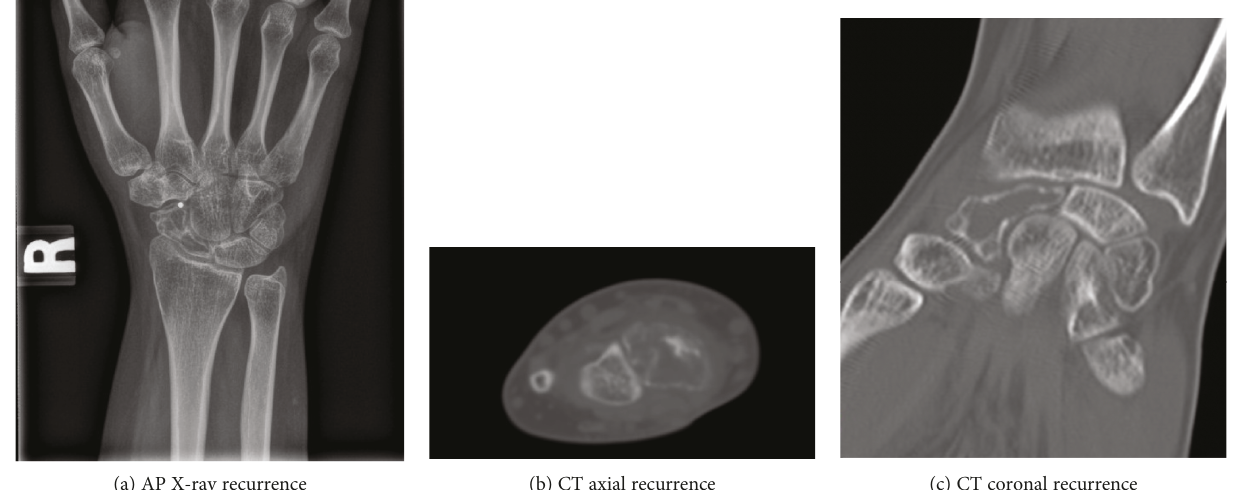
Figure 5: (a – c) AP radiograph (a) and axial and coronal CT scans (b, c) of the right wrist, demonstrating increased lucency and graft resorption within the scaphoid, consistent with local recurrence of the giant-cell tumor of bone.